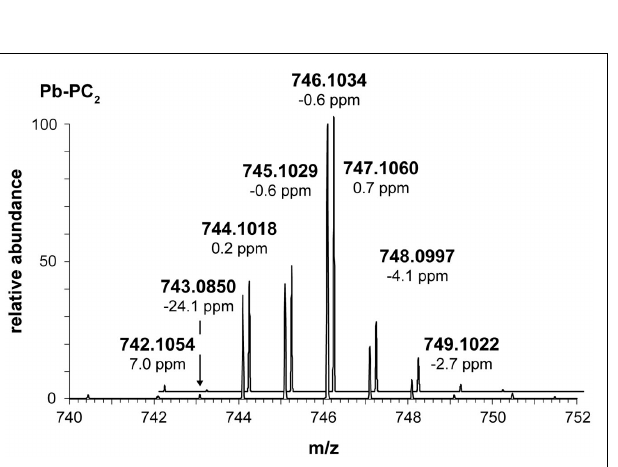
FIGURE 1 | Nano-ESI-MS full-scan spectrum ( m / z 300–1,600) of 0.5mM PC 2 (C 18 H 29 N 5 O 10 S 2 ) and 0.25mM Pb(NO 3 ) 2 in 100mM NH 4 CH 3 COO, 50mM (NH